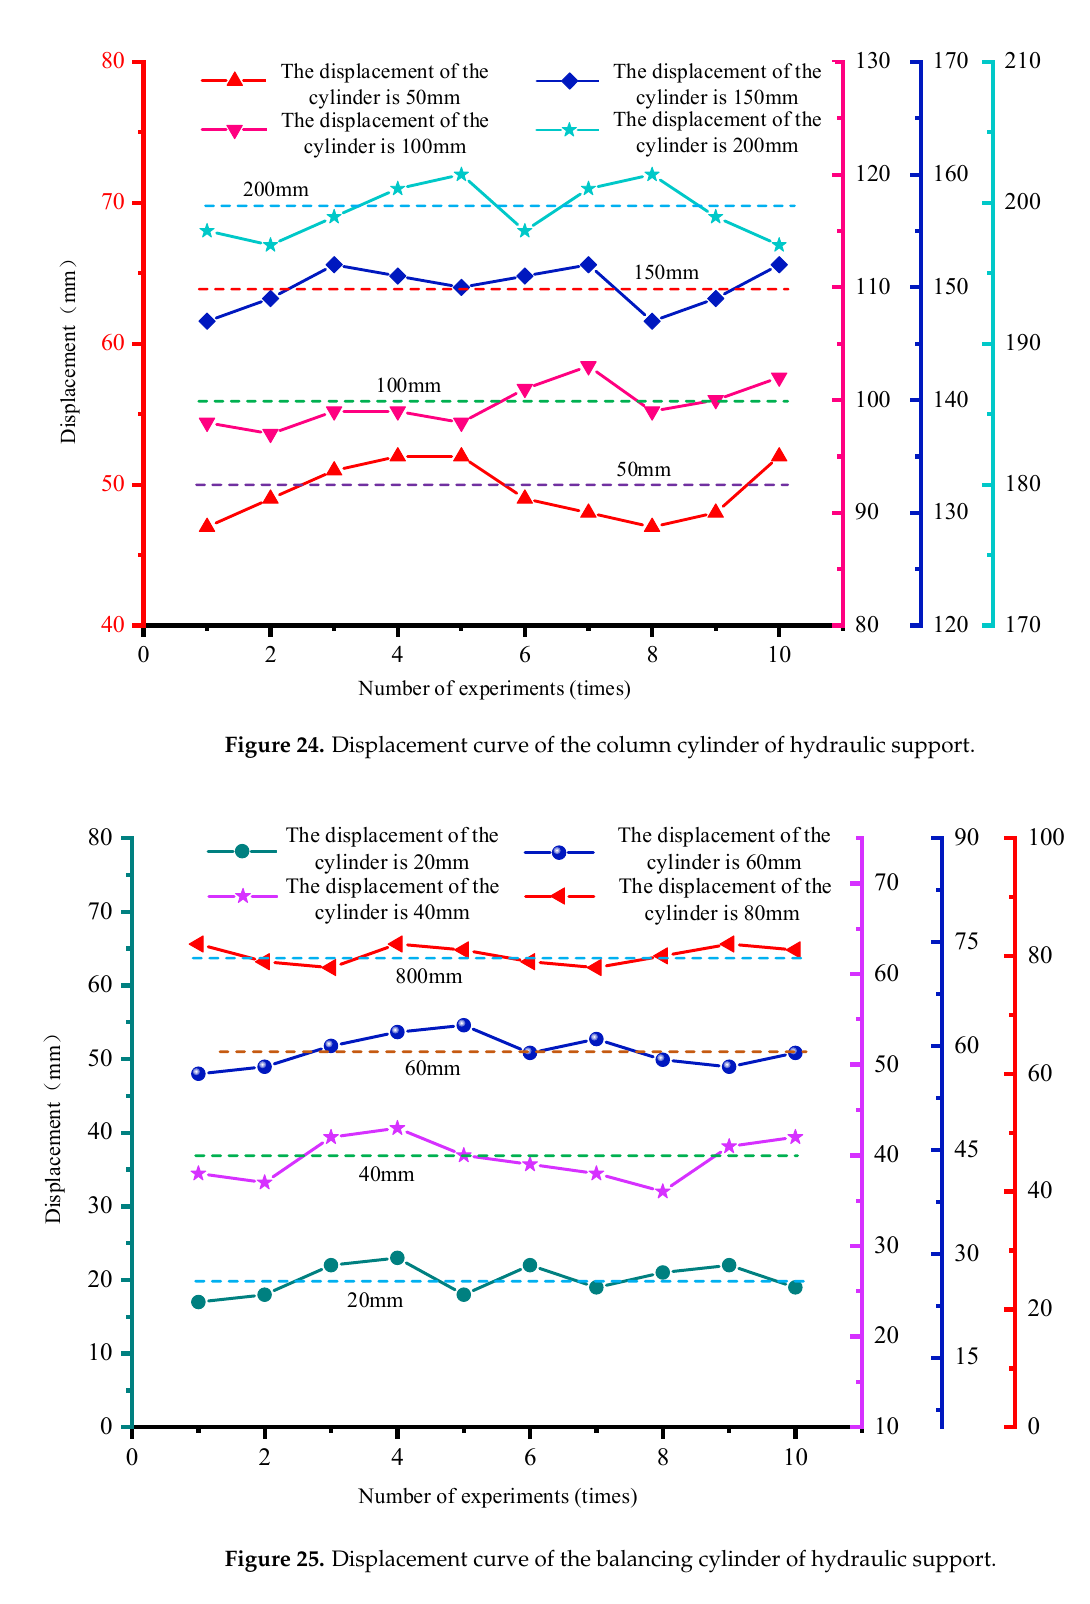
Figure 25. Displacement curve of the balancing cylinder of hydraulic support. The displacement curves of the pushing cylinder of hydraulic support is shown in Figure 26. According to the analysis of the moving cylinder displacement curve shown in Figure 26, the positioning error is ±2 mm when the moving cylinder displacement of the reference support is set to 20 mm, ±2 mm when the moving displacement is set to 20 mm, from −1 mm to +2 mm when the moving displacement is set to 60 mm, and from −3 mm to +2 mm when the moving displacement is set to 80 mm.